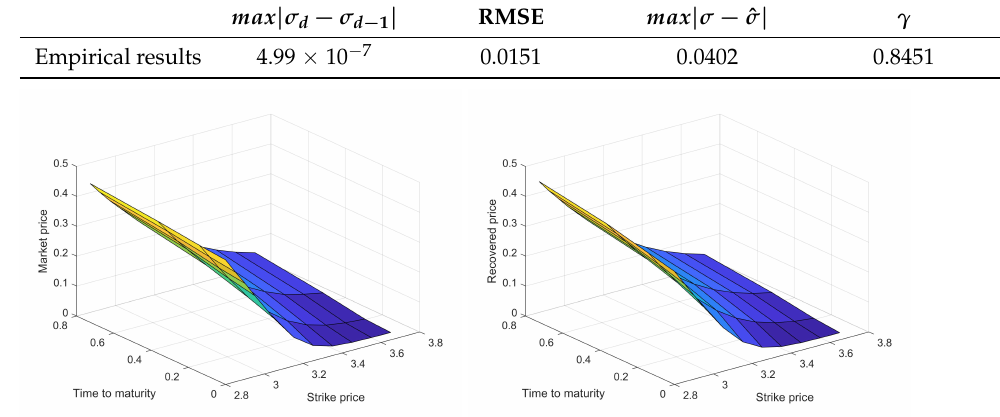
Figure 5. Left: Market prices; Right: Recovered prices.